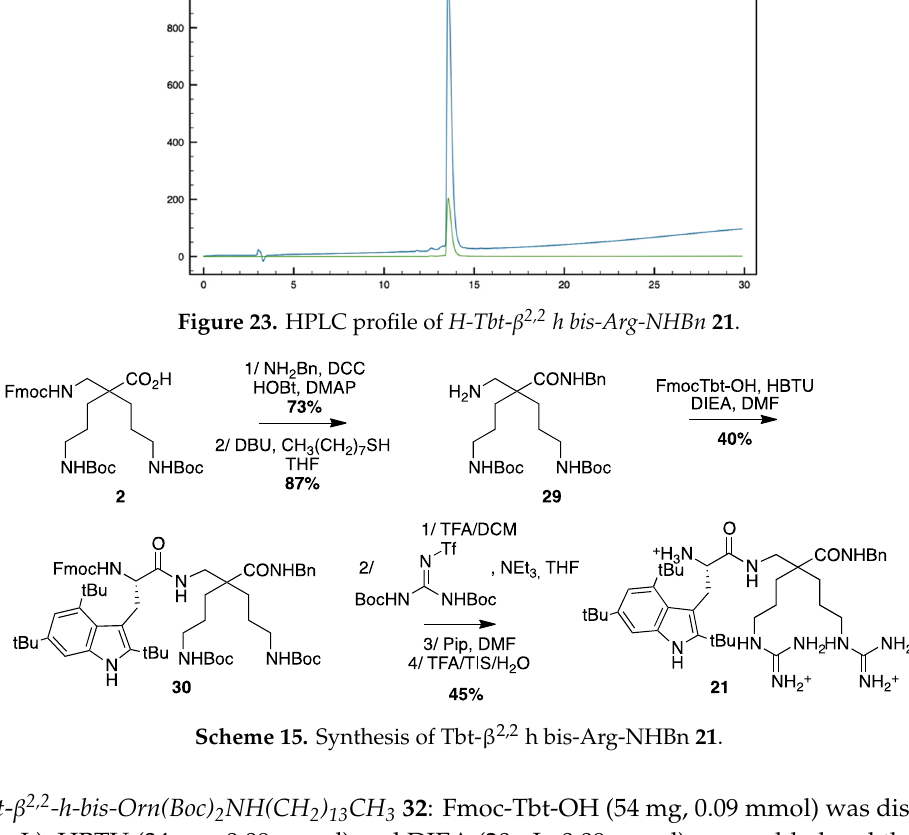
Figure 22 . HPLC profile of H-Tbt- β 2,2 h bis-Arg-OBn 20